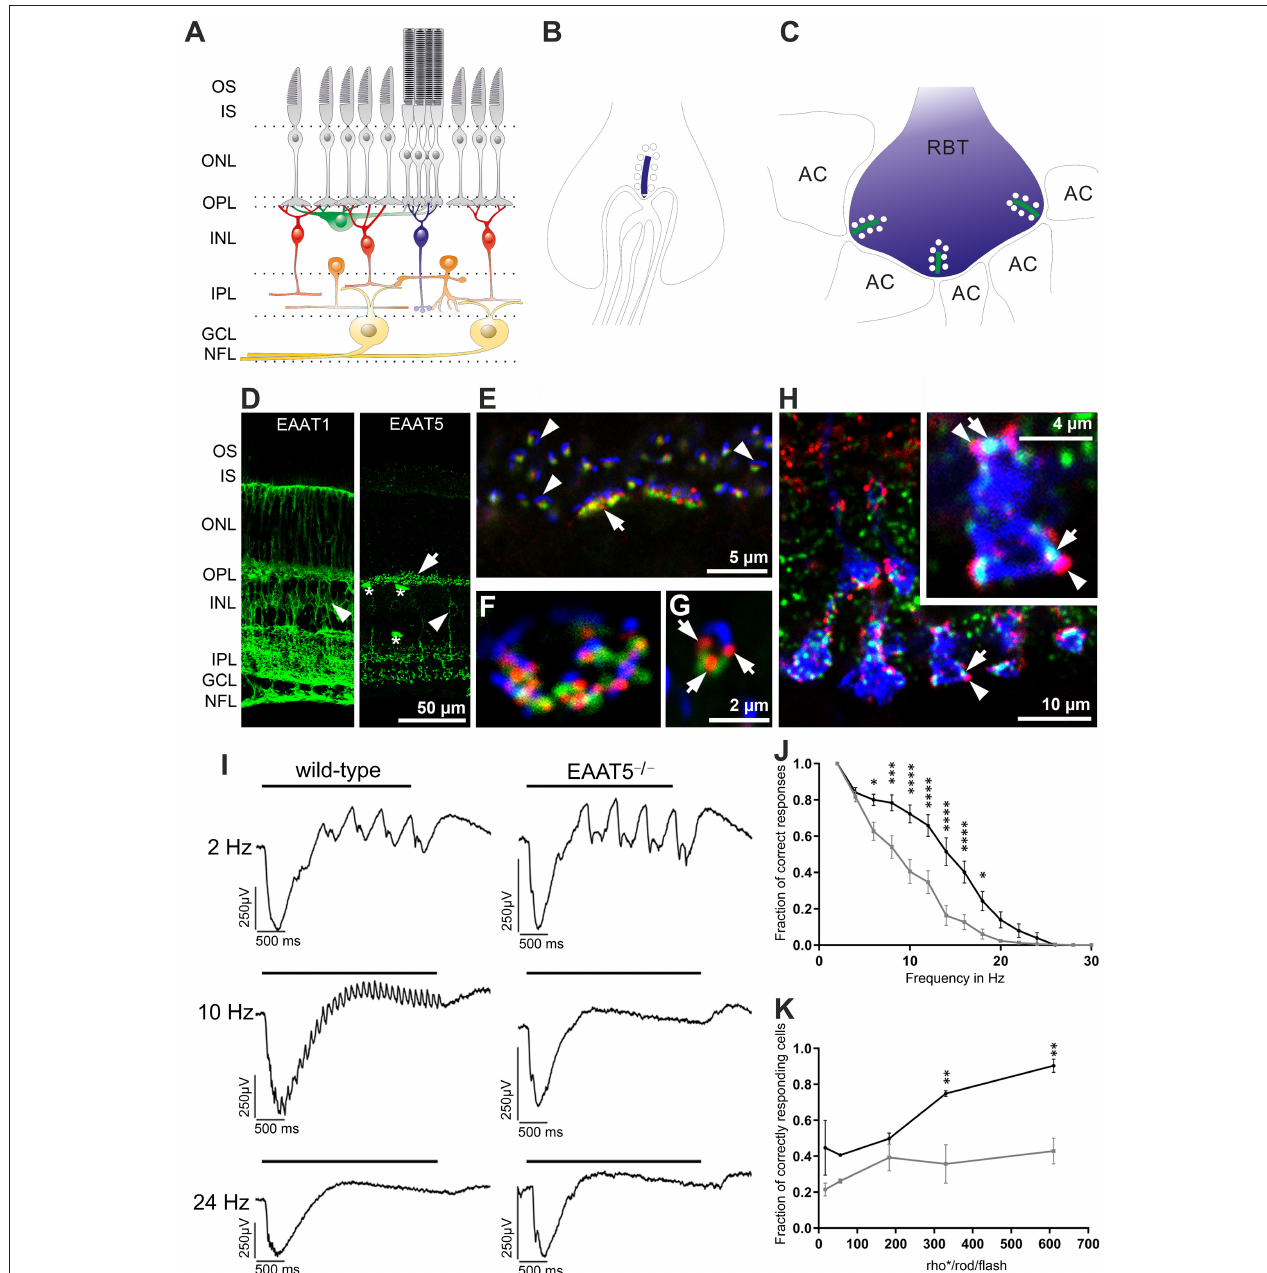
FIGURE 6 | Expression and role of EAAT5 in the retina. (A) Schematic diagram of the retinal network (photoreceptors in gray, horizontal cells in green, cone bipolar cells in red, rod bipolar cell in blue, amacrine cells in orange, ganglion cells in yellow) with synapses formed in the outer plexiform layer (OPL) and inner plexiform layer (IPL). GCL, ganglion cell layer; INL, inner nuclear layer; IPL, inner plexiform layer; IS, inner segments; NFL, nerve fiber layer; ONL, outer nuclear layer; OPL, outer plexiform layer; OS, outer segments. (B) Synapse at a rod terminal with presynaptic ribbon (blue) and invaginating post-synaptic processes of bipolar and horizontal cells. (C) Synapses at a rod bipolar terminal (RBT) with two post-synaptic amacrine processes (AC) per ribbon (green). (D) Comparison of EAAT1 (left) and EAAT5 (right) expression. EAAT1 is widely expressed in retinal Müller cells (arrowhead), whose processes span the entire retina. EAAT5 is mostly found in bright puncta (arrow) in both OPL and IPL and is expressed weakly in some bipolar cell bodies (arrowhead). Asterisks mark blood vessels stained unspecifically by the secondary antibody. (E–G) Triple staining with antibodies against mGluR6 (green, on ON-bipolar cell dendrites), EAAT5 (red), and piccolo (blue, synaptic ribbon, glutamate-release site) in the OPL of a wild-type retina. (E) EAAT5 puncta are always highly associated with the glutamate-release site. Arrow: cone terminal; arrowheads: rod terminals. (F) Higher magnification image showing the terminal of a cone in horizontal view. (G) Rod terminal in side view (three EAAT5 puncta are seen at the rod terminal, arrows). (H) Triple staining in the IPL, showing close association of EAAT5 puncta (red, arrowheads) with the synaptic ribbons (green, arrows) on rod bipolar cell terminals (blue, colors correspond to scheme in C ). (I) Recordings of local field potentials in response to flicker stimuli of different frequencies. In contrast to the wild-type retina (left), EAAT5 − / − retina (right) did not resolve the 10-Hz flicker stimulus. Bar represents duration of the flicker stimulus (total stimulus duration: 3s; individual flash